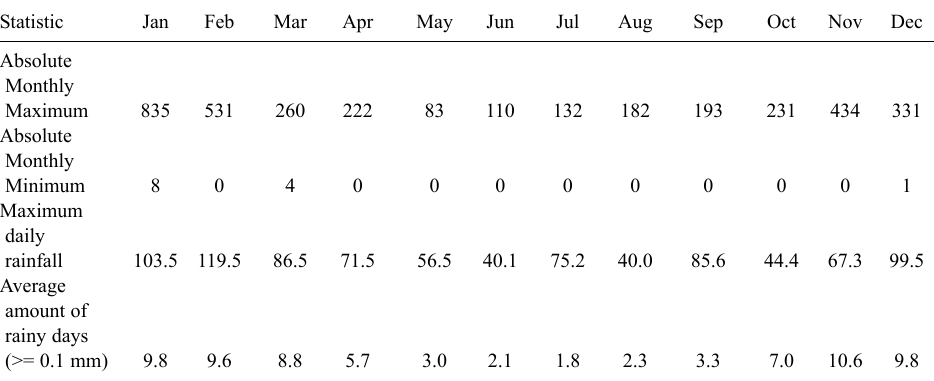
Rainfall statistics (mm) for the period 1912 to 2001